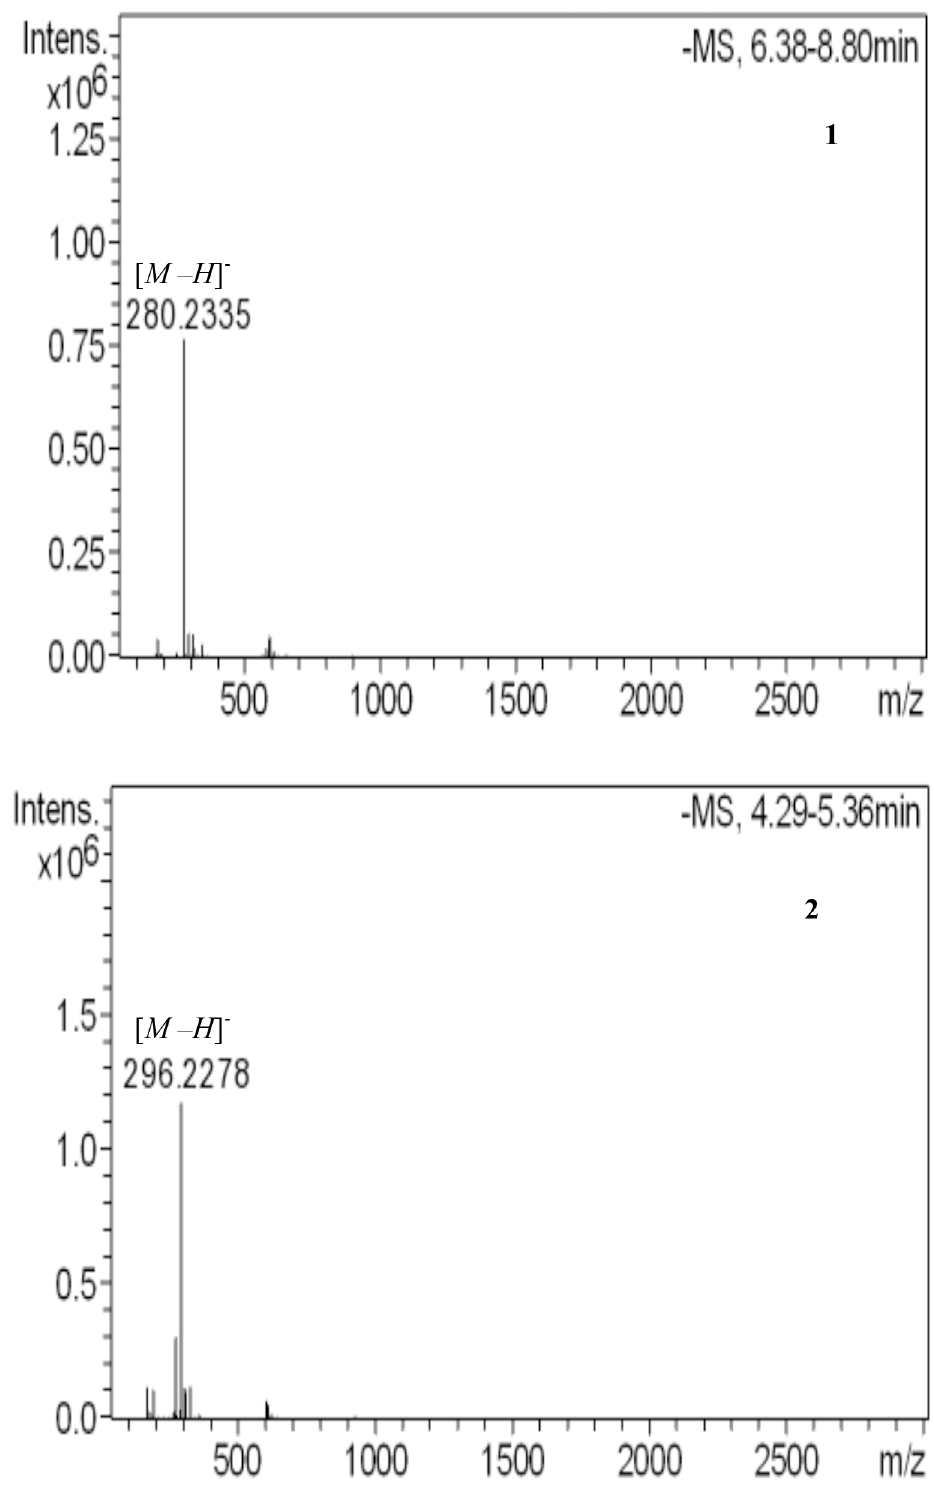
Fig 4. LC-MS analysis of linoleic acid and synthesis compounds. (1) Linoelic acid. (2) Monoepoxidation. (3) Oxirane ring opening. (4) Esterification. (5) Acetlyation.